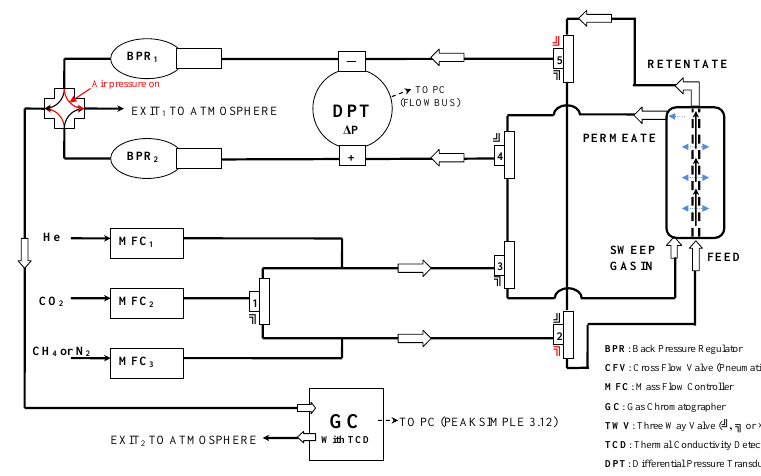
Figure 13. Scheme of membrane testing rig for gas separation measurements under continuous flow.